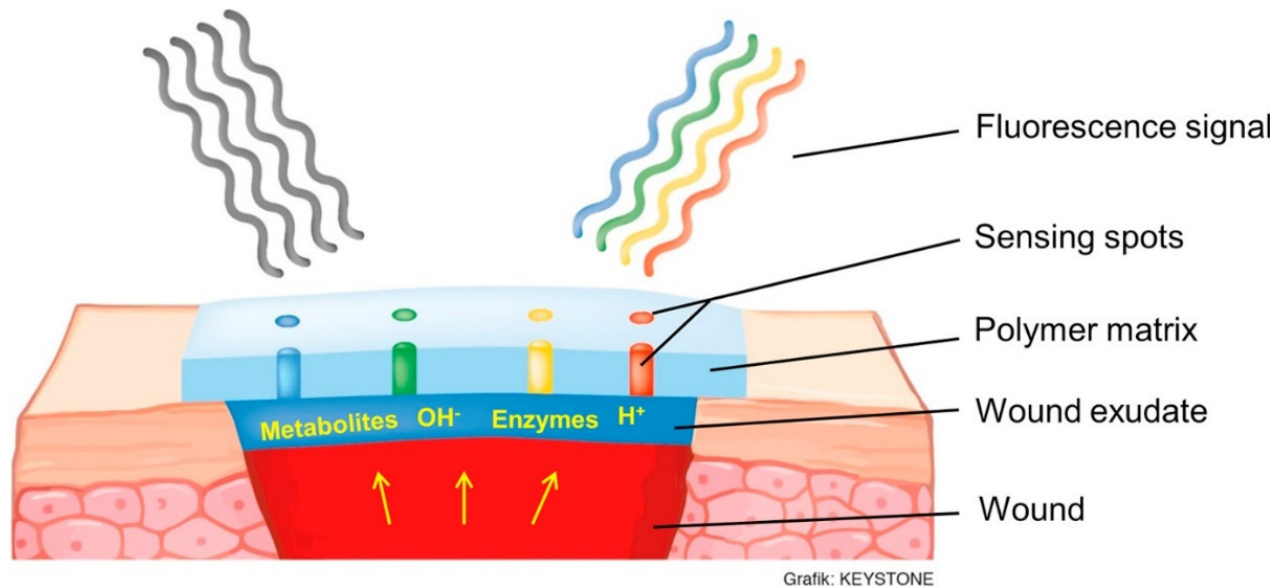
Figure 5. Scheme of the sensing principle for non-invasive wound monitoring based on the detection of pH-values and glucose concentrations. Reprinted from Reference [65] with permission from Elsevier. License Number: 5176700564947.